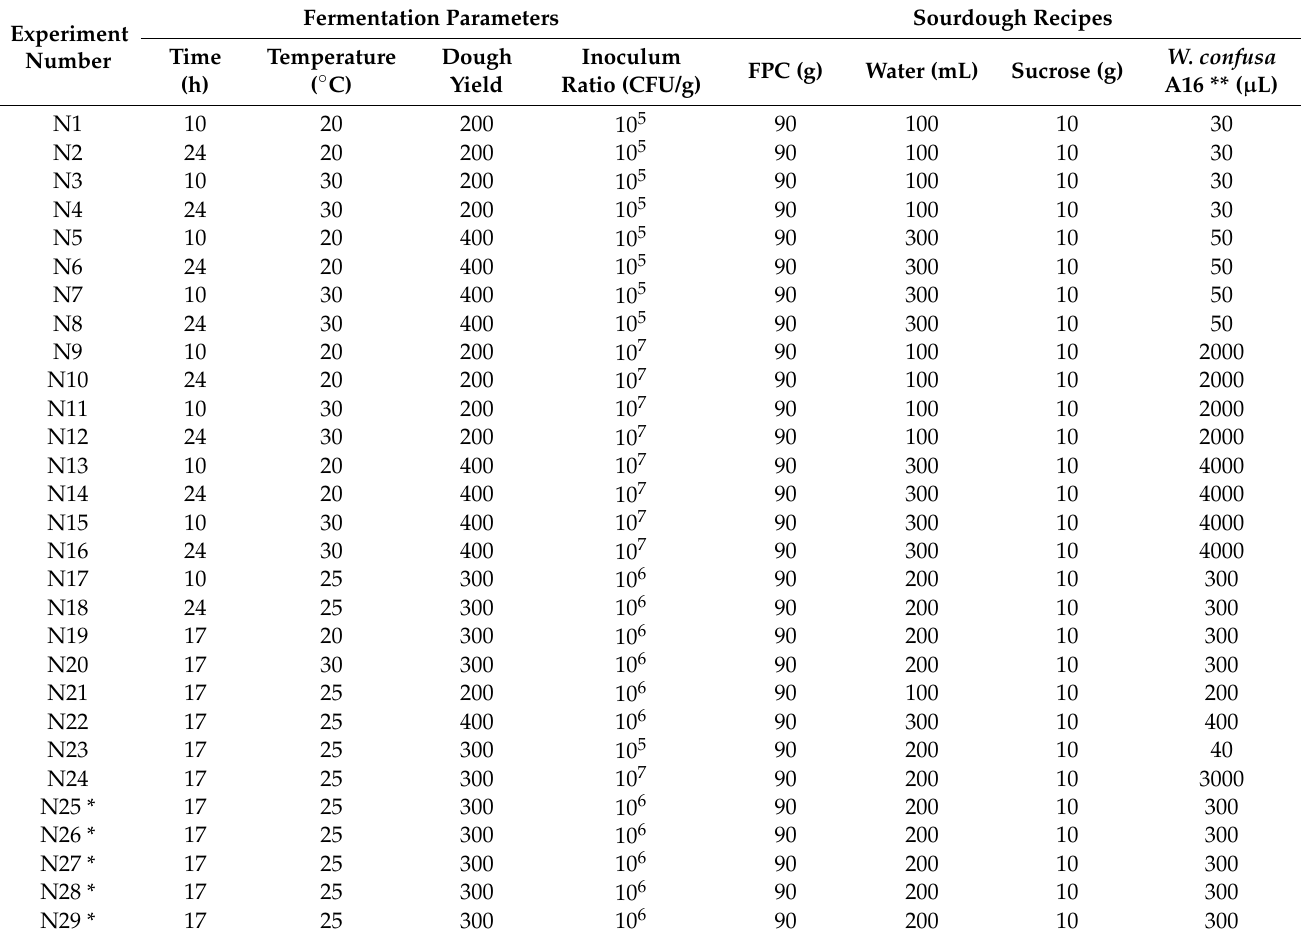
Table 1. Experimental design matrix: fermentation parameters and sourdoughs